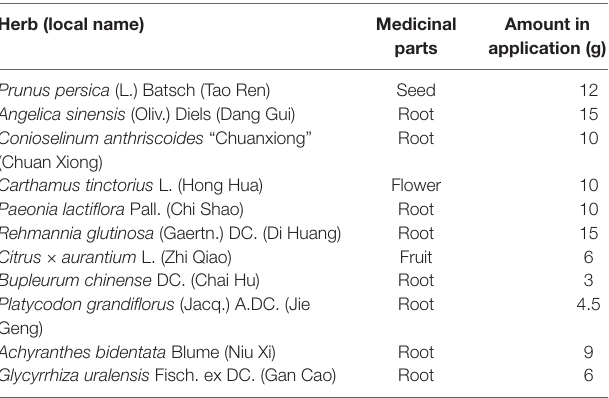
TABLE 1 | Botanical compositions of Xuefu Zhuyu decoction. Herb (local name) Medicinal